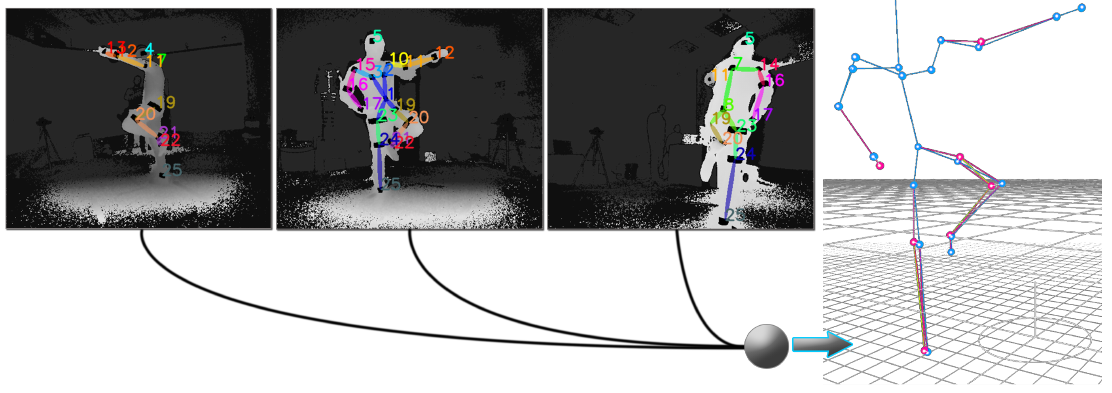
Figure 8. Multiple 2D reflector-set estimates ( left ) are spatially mapped in a global 3D Cartesian coordinate system, resulting in 3D optical data extraction ( right